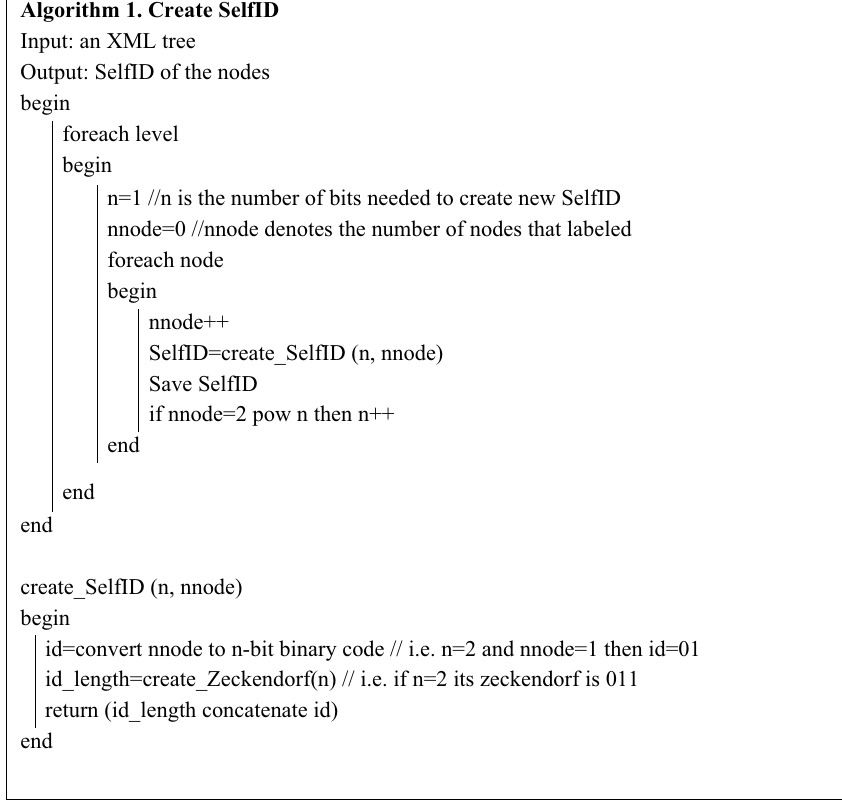
Algorithm 1. Create